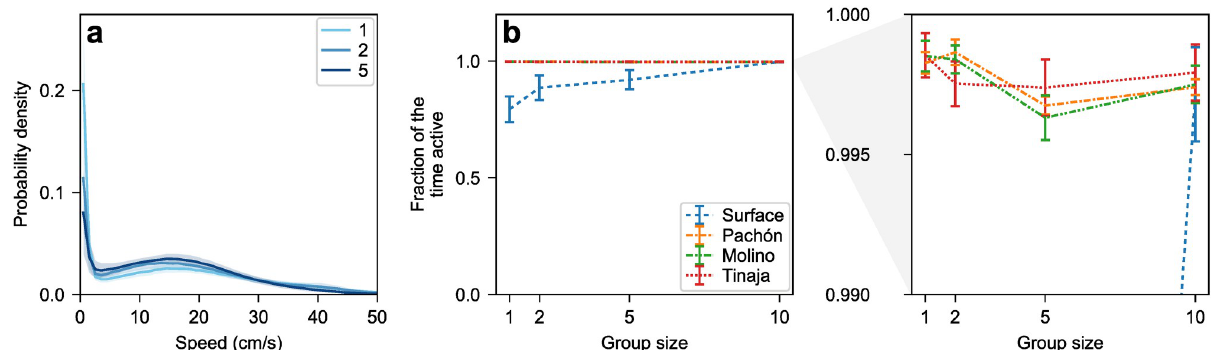
Fig 2. (a) Speed distribution of surface fish as a function of group size. The halo around each curve corresponds to one standard error on either side of the mean. A sharp peak near zero indicates fish are not moving. The area under the peak is the fraction of the time the fish are not moving. (b) Fraction of time spent moving faster than 1 cm/s (“active”) as a function of group size. Cavefish are almost always moving (they are active > 99% of the time in every trial regardless of population or group size), whereas surface fish are less active when they are more isolated (linear regression slope 0.02 cm/s/fish, N = 52, p = 0.007). (c) Same as (b), zooming in on the cave